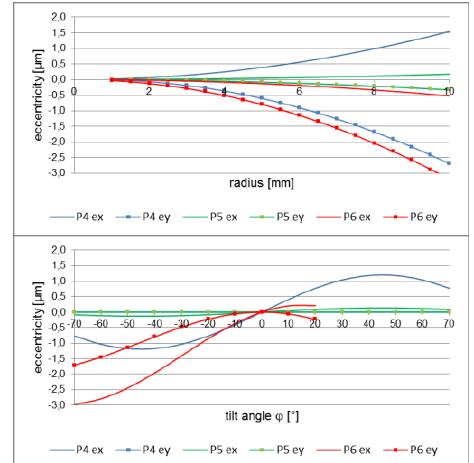
Figure 8: Eccentricity in projection of circular targets as a function of target radius (left,  =20°, j =10°) and tilt angle (right, with r =5mm) Figure 9: Eccentricity in projection of a spherical target at points P3 and P6 as a function of target radius (top), and for P1 and P4 as a function of exterior orientation angle j (bottom) Figure 9 (left) shows the resulting eccentricity for a spherical target as a function of the radius. The targets correspond to point P3 in Table 1 (video camera) and P6 in Table 2 (SLR camera). The curves show the resulting values for ex and ey for both camera types. As with the flat target tests, the eccentricity for the SLR setup is larger than for the video camera due to the larger scale (smaller scale numbers in Table 2) and the